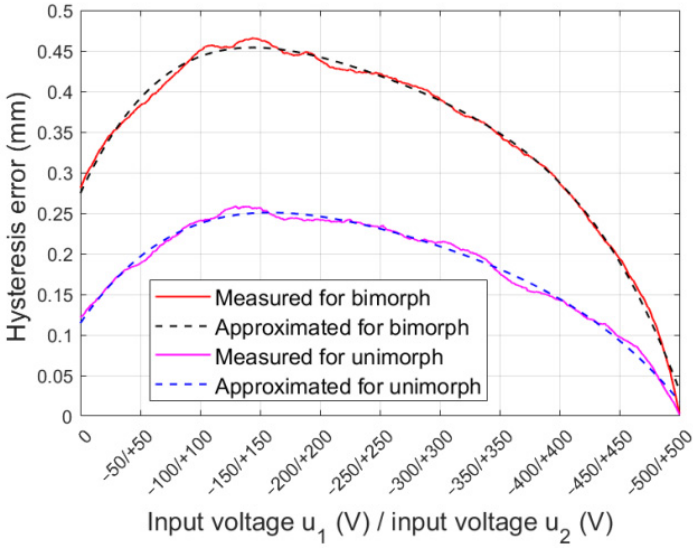
Figure 15. Selected results of the regression analysis for bimorph, u 1max = +500 V, u 2max = –500 V; and for unimorph, u max = u 1max = +500 V.